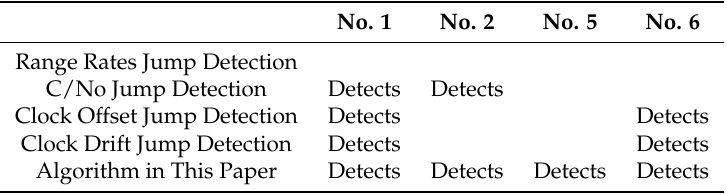
Table 2. Different methods’ detection